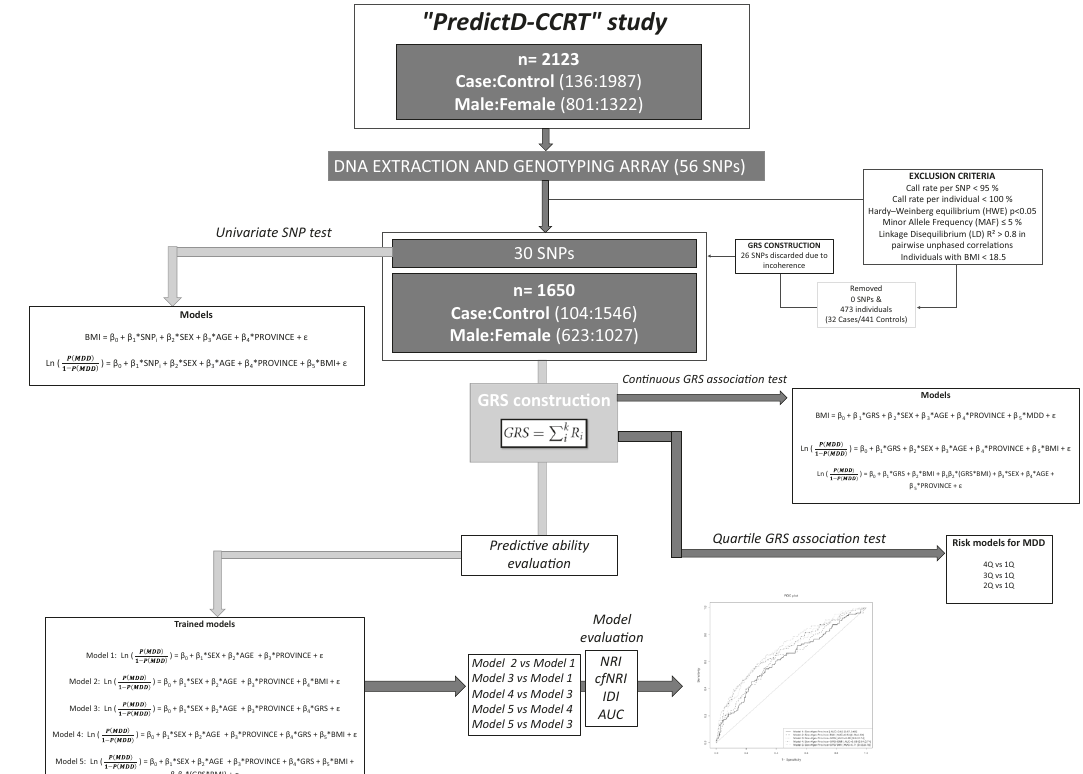
Fig. 1 Complete work fl ow detailing the study design and statistical analyses performed: quality control process, association analysis and construction and evaluation of predictive models. AUC area under the receiver operating characteristic curve, cfNRI the category-free net reclassi fi cation improvement, HWE Hardy – Weinberg equilibrium, IDI integrated discrimination improvement, LD linkage disequilibrium, MAF minor allele frequency, MDD major depressive disorder, NRI net reclassi fi cation improvement, SNP single nucleotide